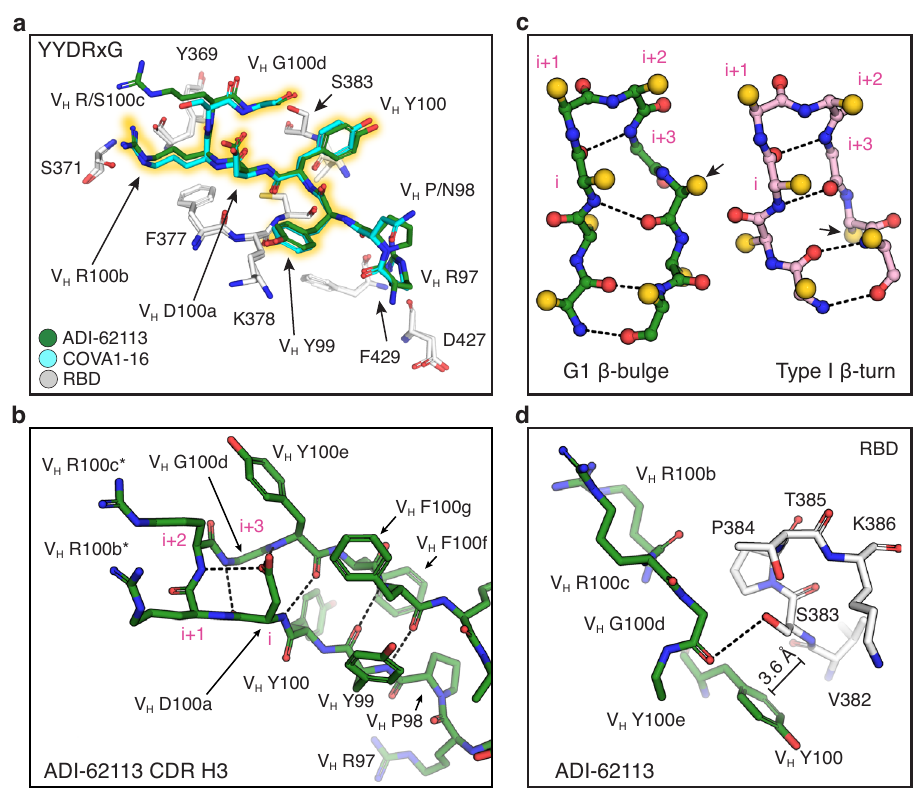
Fig. 2 The YYDRxG motif is a recurring feature in CDR H3 for RBD binding. Hydrogen bonds are shown as dashed lines. Key epitope and paratope residues are shown in sticks and labeled. a Comparison of CDR H3 interactions of ADI-62113 and COVA1-16 with the RBD. White, SARS-CoV-2 RBD; green, ADI-62113; cyan, COVA1-16. The 99 YYDRxG 100d hexapeptide is highlighted in yellow to show its conserved structure in CDR H3 that interacts with the RBD. b The YYDRxG motif is located at the tip of CDR H3 and precedes a G1 β -bulge in the descending strand of the hairpin structure. Residues in the β -turn at the tip of CDR H3 are numbered i to i + 3 (magenta). The V H D100a carboxyl (residue i) hydrogen bonds to backbone amide of V H R100c (i + 2) in the β -turn as well as the backbone amide of V H Y100e in the β -bulge. Asterisk (*) indicates somatically mutated residue. c Backbone comparison of an inserted β -bulge versus a standard β -strand in a β -sheet. Schematic backbones show the β -harpin in ADI-62113 CDR H3 that contains a G1 β -bulge following the glycine residue (i + 3) in the β -turn and comparison with a standard β -hairpin also with a type 1 β -turn at its tip (PDB ID: 4H5U). Amino-acid side chains are simpli fi ed as gold spheres. Arrows indicate the register change between the two motifs due to an additional residue in the β -hairpin in ADI-62113. d Limited space between residue V H G100d and RBD favors a glycine residue at this position in the β -bulge. A hydrogen bond is formed between the V H G100d carbonyl oxygen and S383 hydroxyl in the RBD. An amide- π interaction is formed between V H Y100 and the peptide backbone of 382 VS 383 of SARS-CoV-2